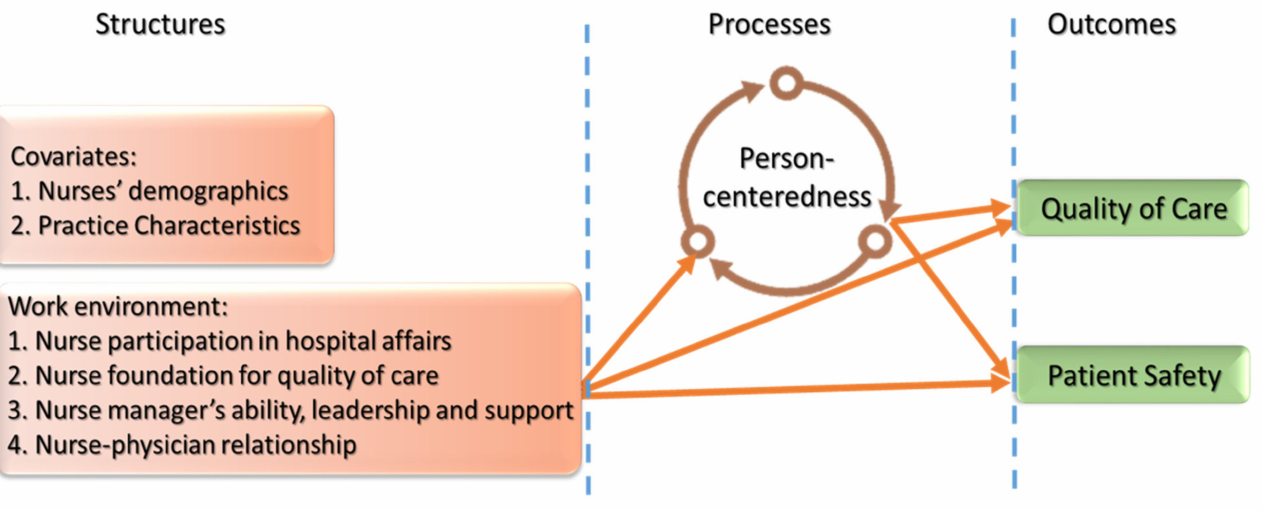
Figure 1. Research